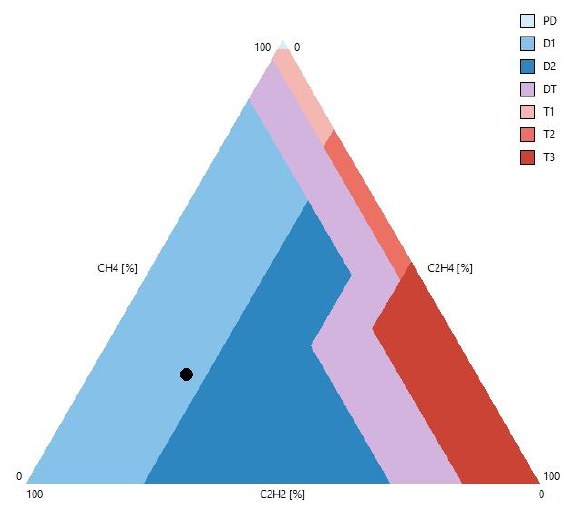
Figure 3. Defect indicated by the Duval Triangle Method for 30 MVA, 110/10.5 kV power transformer performed after an emergency shutdown of the transformer.